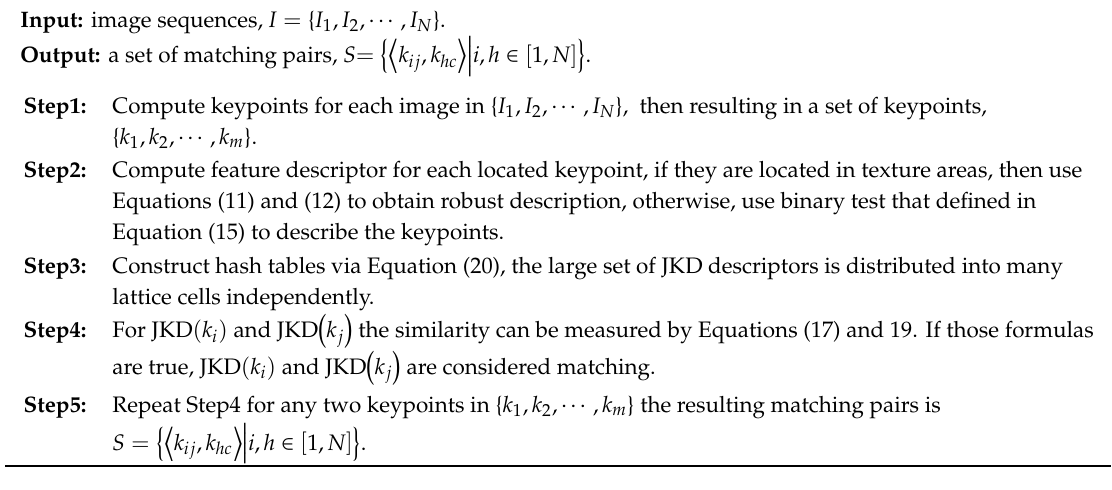
Algorithm 1 Superpixel-based feature tracking